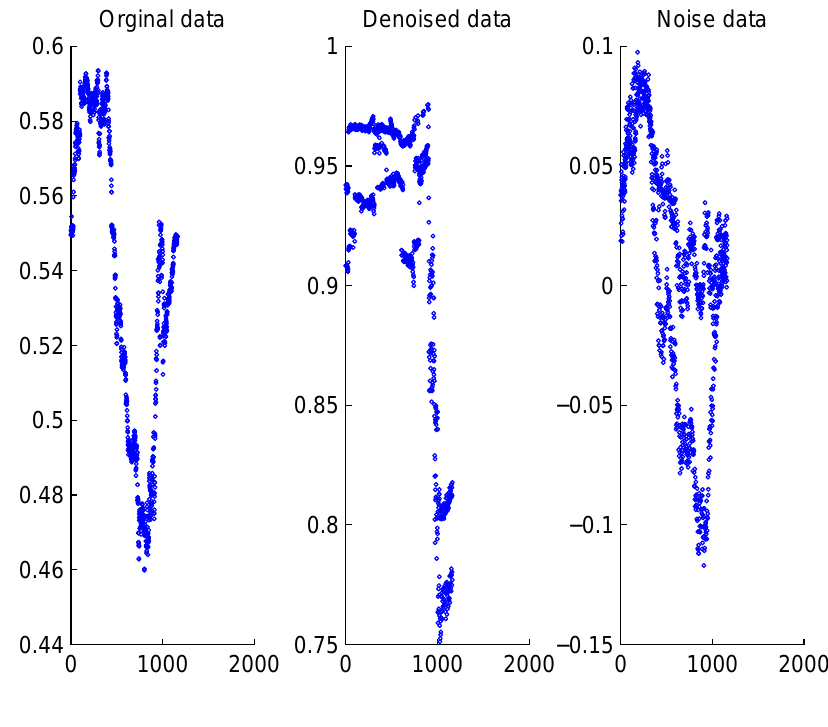
Figure 3. Dynamic correlation between WTI and Brent